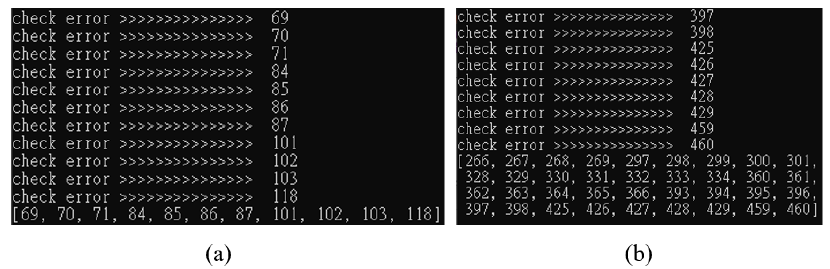
Figure 18. The result of tampered region detection on tampered Lena image ( a ) N = 32 ( b ) N = 16.